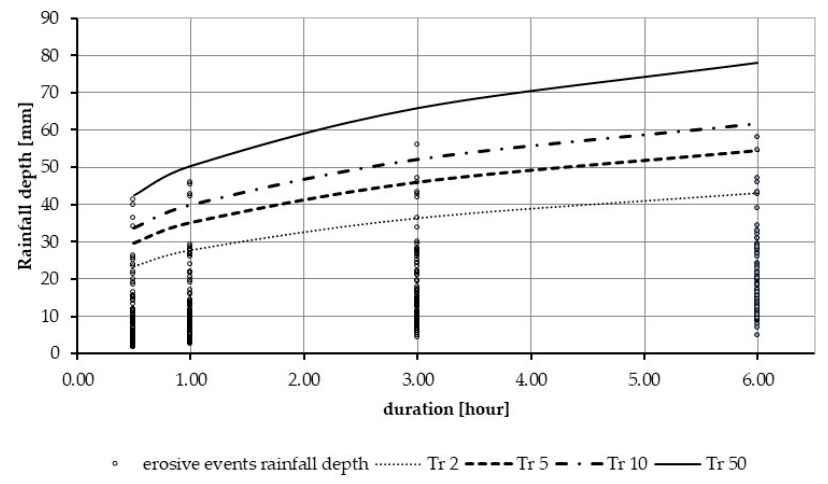
Figure 3. Depth–duration–frequency (DDF) curves for the Frascati rain gauge, with 2, 5, 10, and 50 year return periods and rainfall depth of erosive events (black circles).